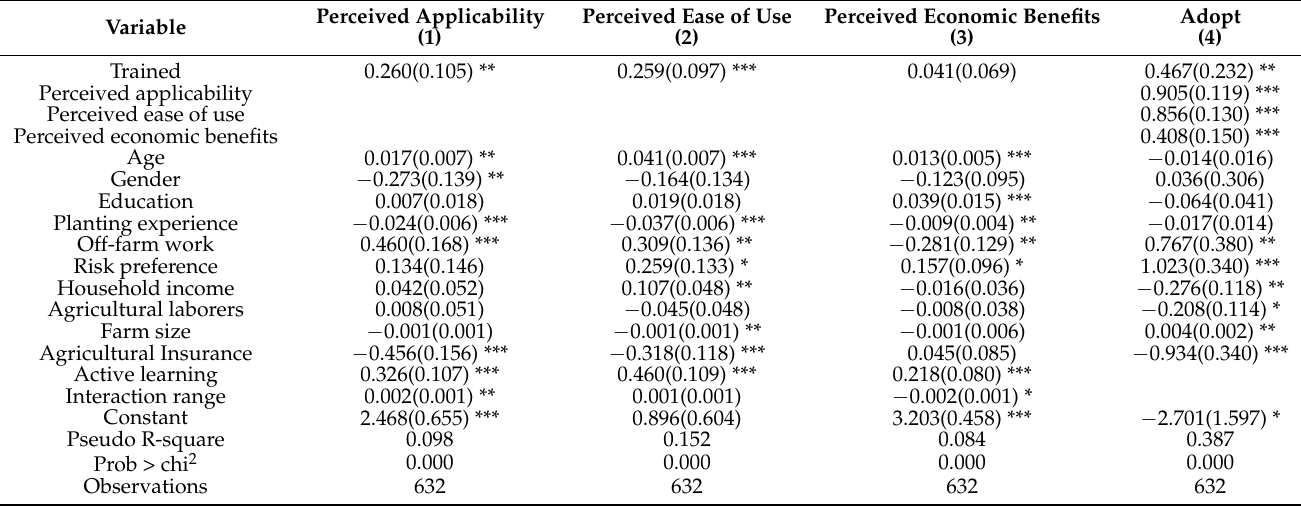
Table 6. The mediating effect of farmers’ absorptive